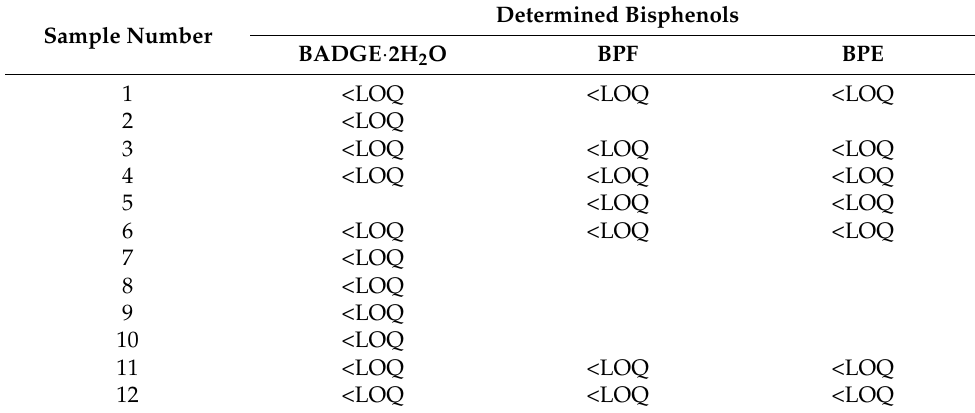
Table 1. Results of determination BPs in 12 different human urine